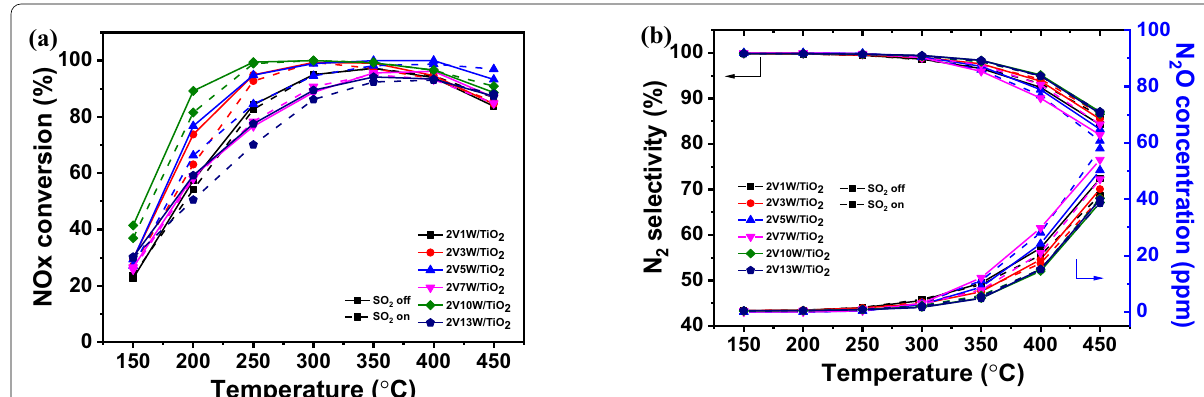
Fig. 7 NOx removal efficiencies of the synthesized SCR catalysts according to tungsten content measured in the temperature range 150–450 °C a NOx conversion and b N 2 selectivity and N 2 O concentration. Reaction conditions: [NOx] [O 2 ] 5%, balance N 2 , total flow 500 sccm, and the gas hourly space velocity (GHSV) =